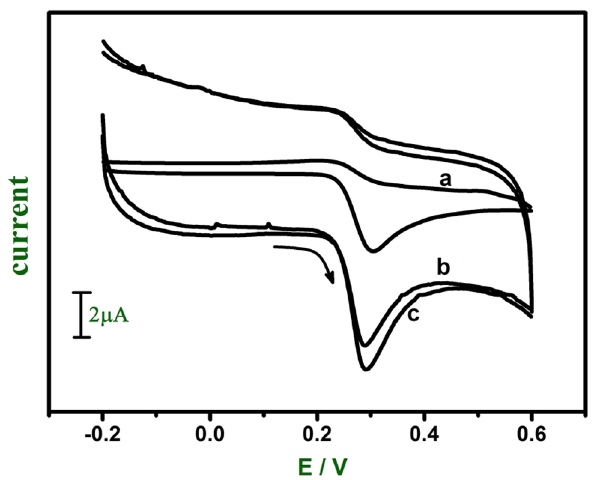
Figure 5. Cyclic voltammograms of 0.06 mM UA at the bare CPE (curve a ), GO (curve b ) and E-GO (curve c ) in 0.2 M phosphate buffer solution at pH 7.0 with sweep rate 0.05 Vs −1 .